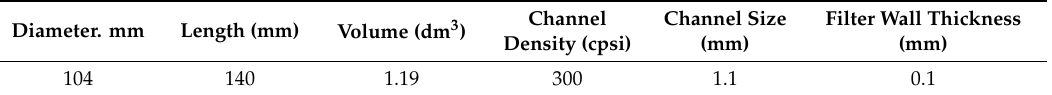
Table 3. Physical properties of the full-sized GPF monolith.